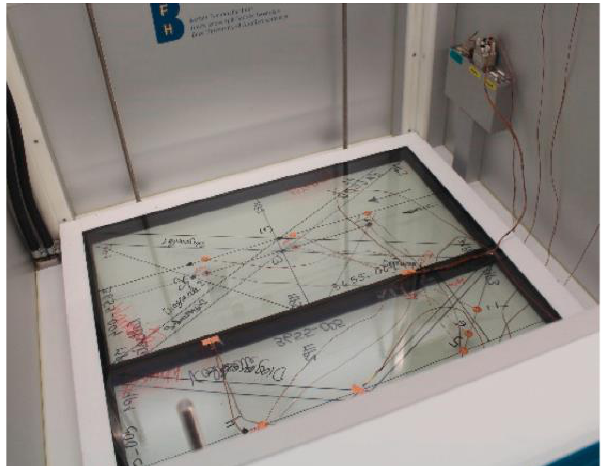
Figure 8. Schematic of the two glued samples of triple-glazed units of 400 mm × 800 mm and the temperature sensors. The door can only be opened in a horizontal position. Reproduced from Ghazi Wakili et al. [57].